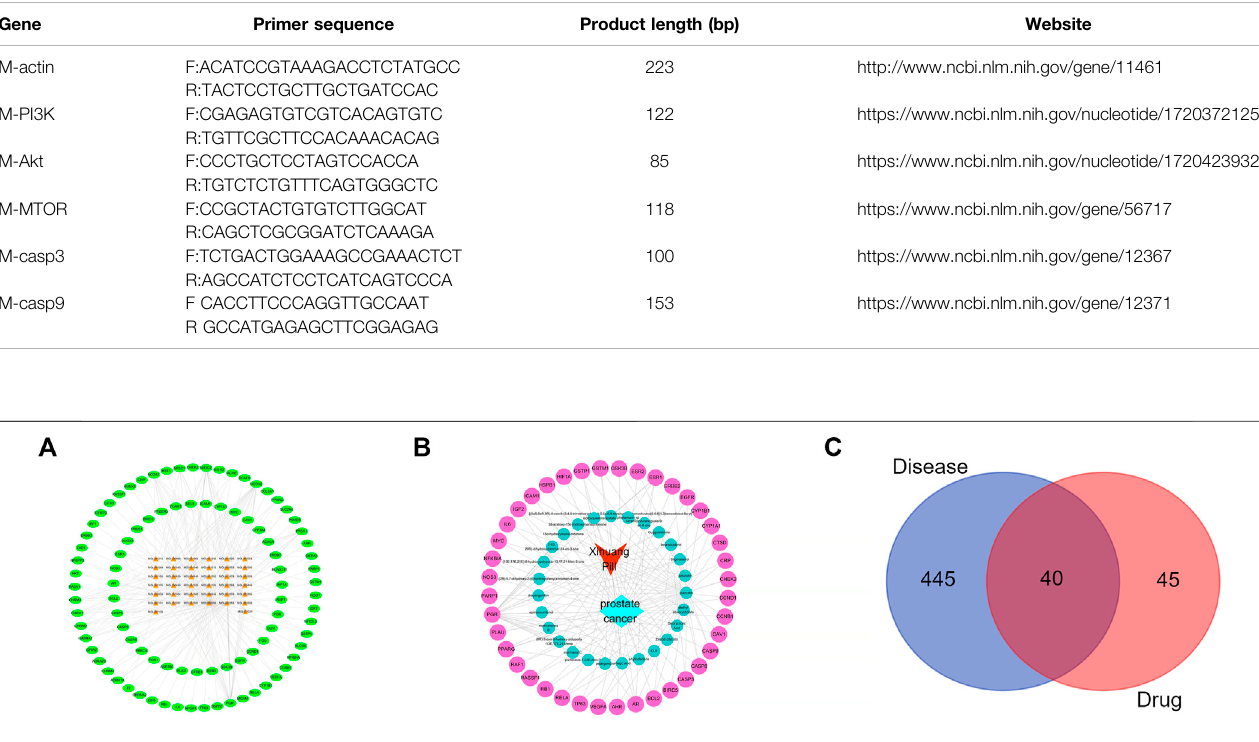
TABLE 1 | Primer design